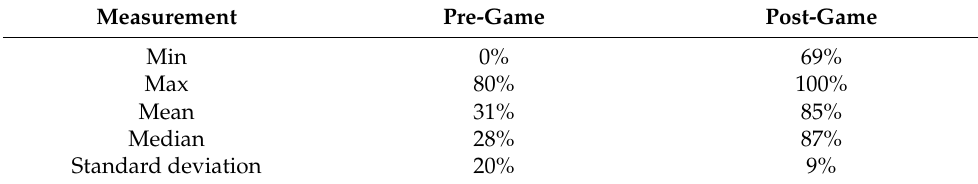
Table 6. Pre-game and post-game measurements.